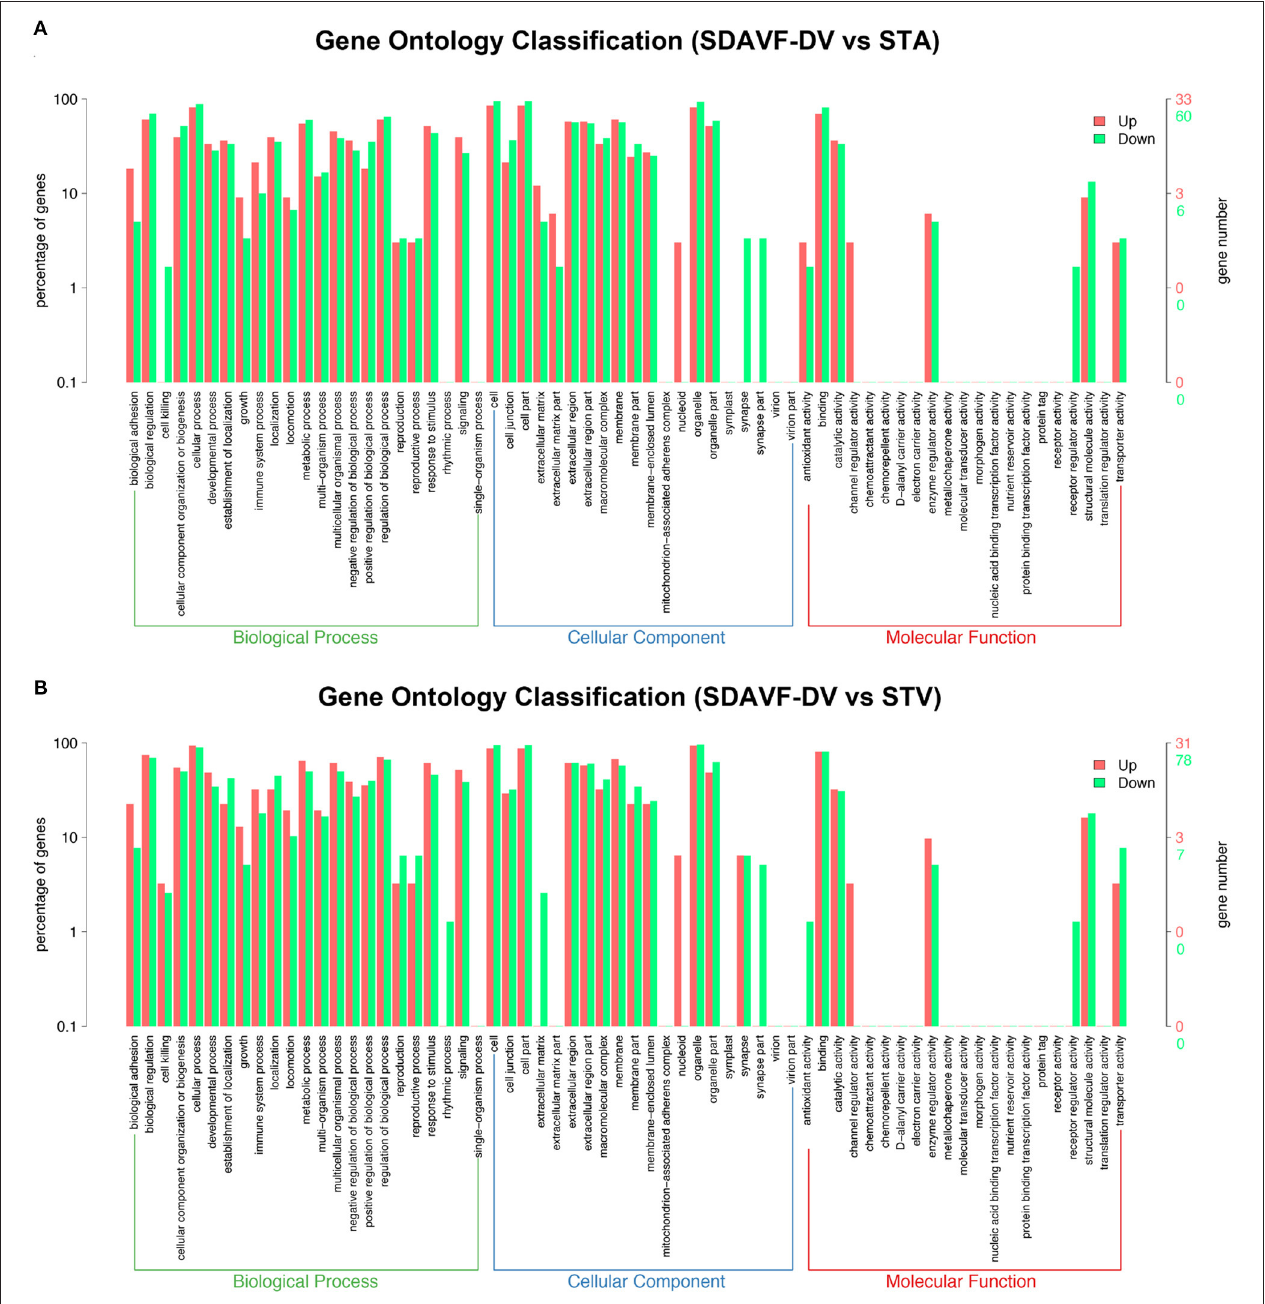
FIGURE 5 | GO analysis of significantly dysregulated proteins and changes in the SDAVF-DV. GO analysis of the up- and downregulated GO terms for the 2.0-fold differentially expressed genes associated with the biological process, cellular component and molecular function categories when comparing the SDAVF-DV with the STA (A) and STV (B)